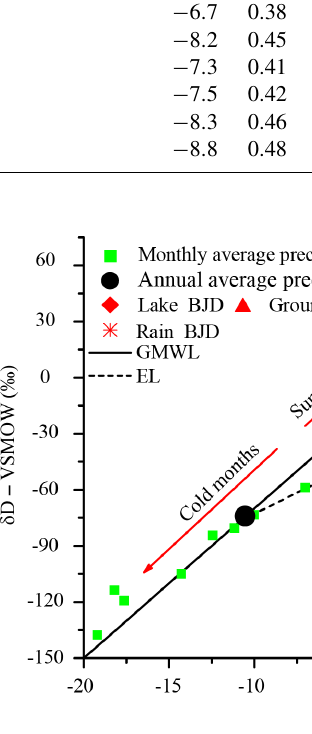
Figure 4. The δ D vs. δ 18 O plot of natural groundwater, lake water and precipitation in the desert. Also shown are weighted monthly average and weighted annually average isotope ratios of precipita- tion at the IAEA-GNIP station in